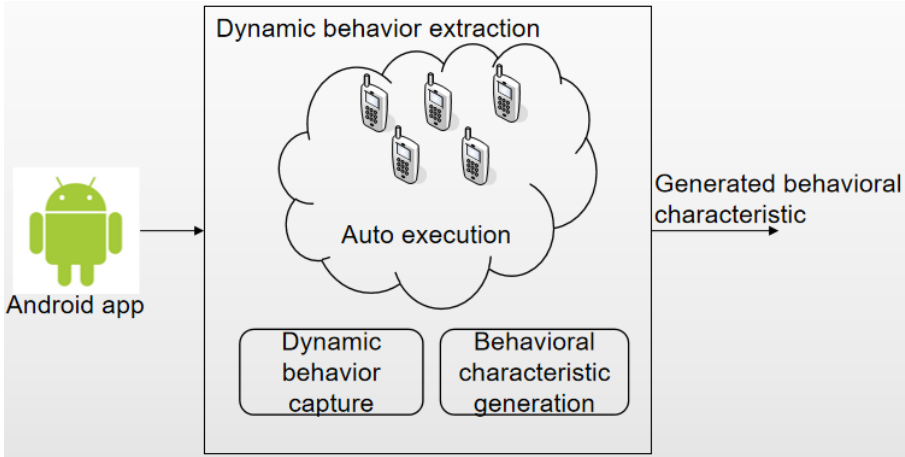
Figure 3. Dynamic behavioral characteristic extraction.